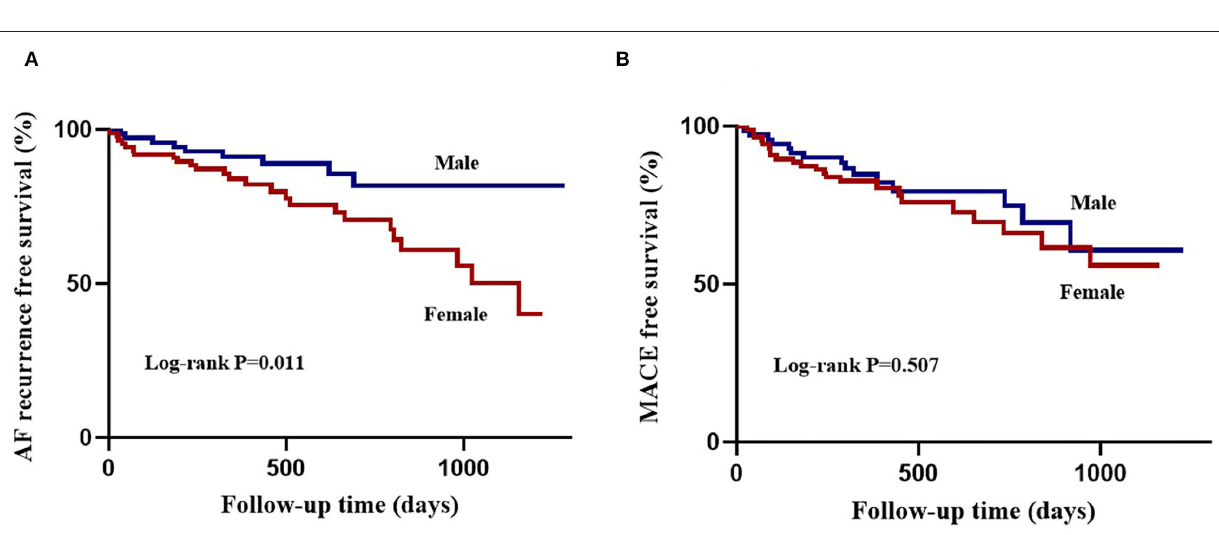
were significantly correlated with MACE. In the